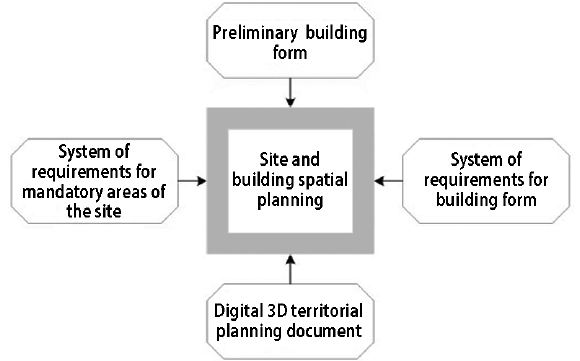
Fig. 2. Elements of the spatial planning process for site and